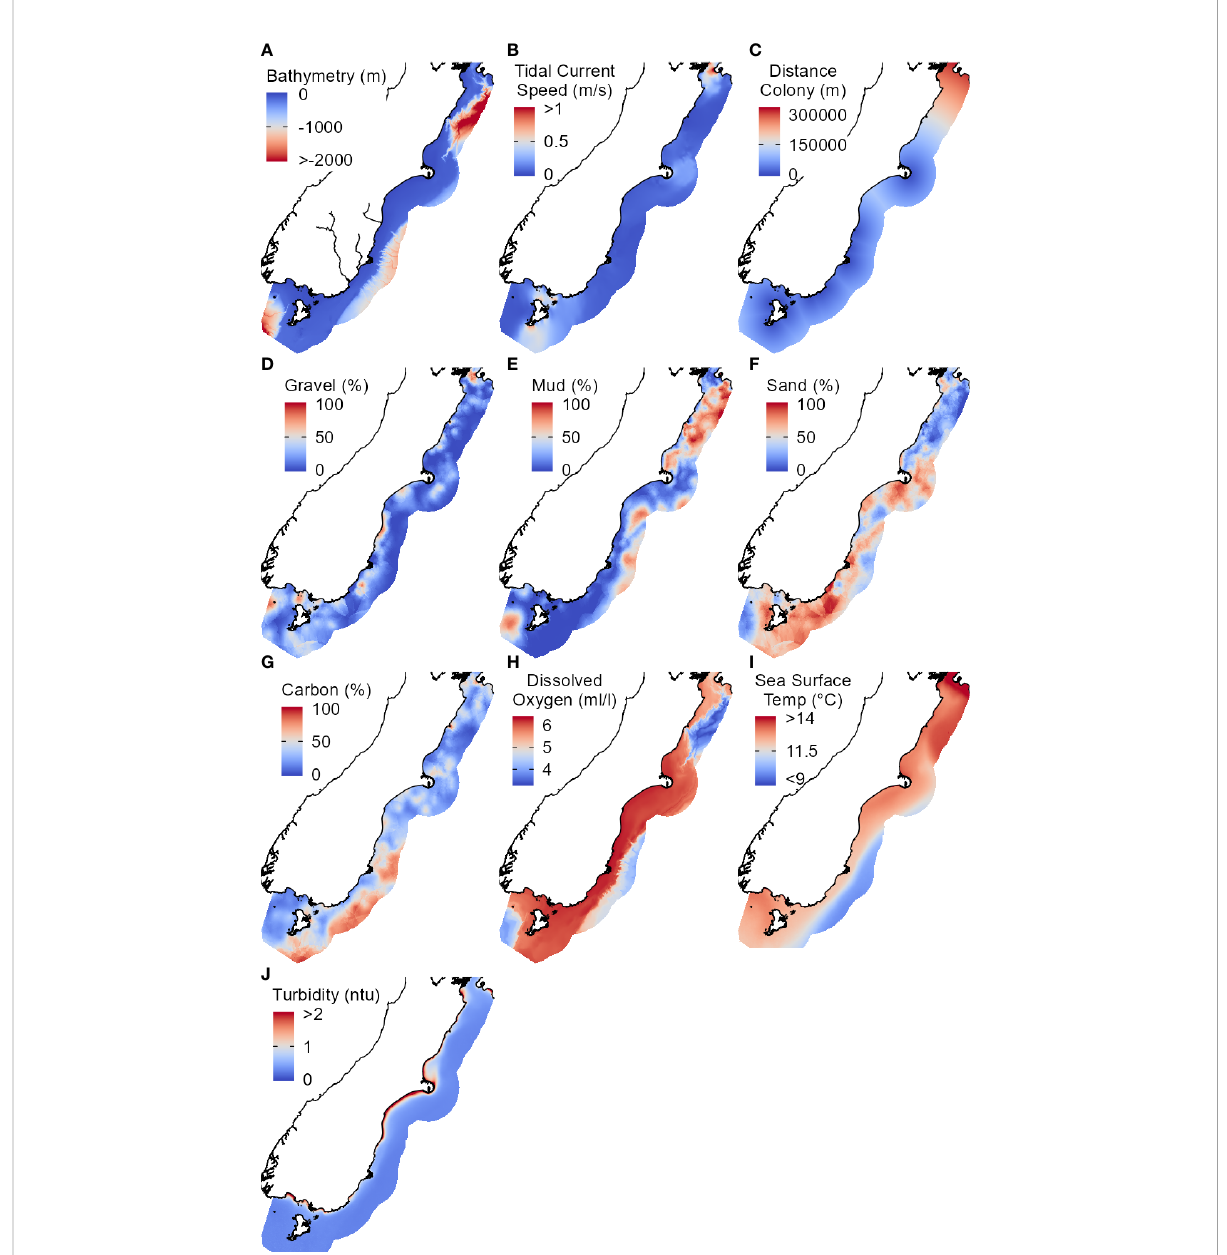
FIGURE 2 Environmental predictors (A-J) used in the fi nal Maxent models. Study extent is a 75 km buffer off the east coast of the South Island, New Zealand. Abbreviations and units correspond to those in Table 2. Colour gradients range from high/maximum (red) to low/minimum